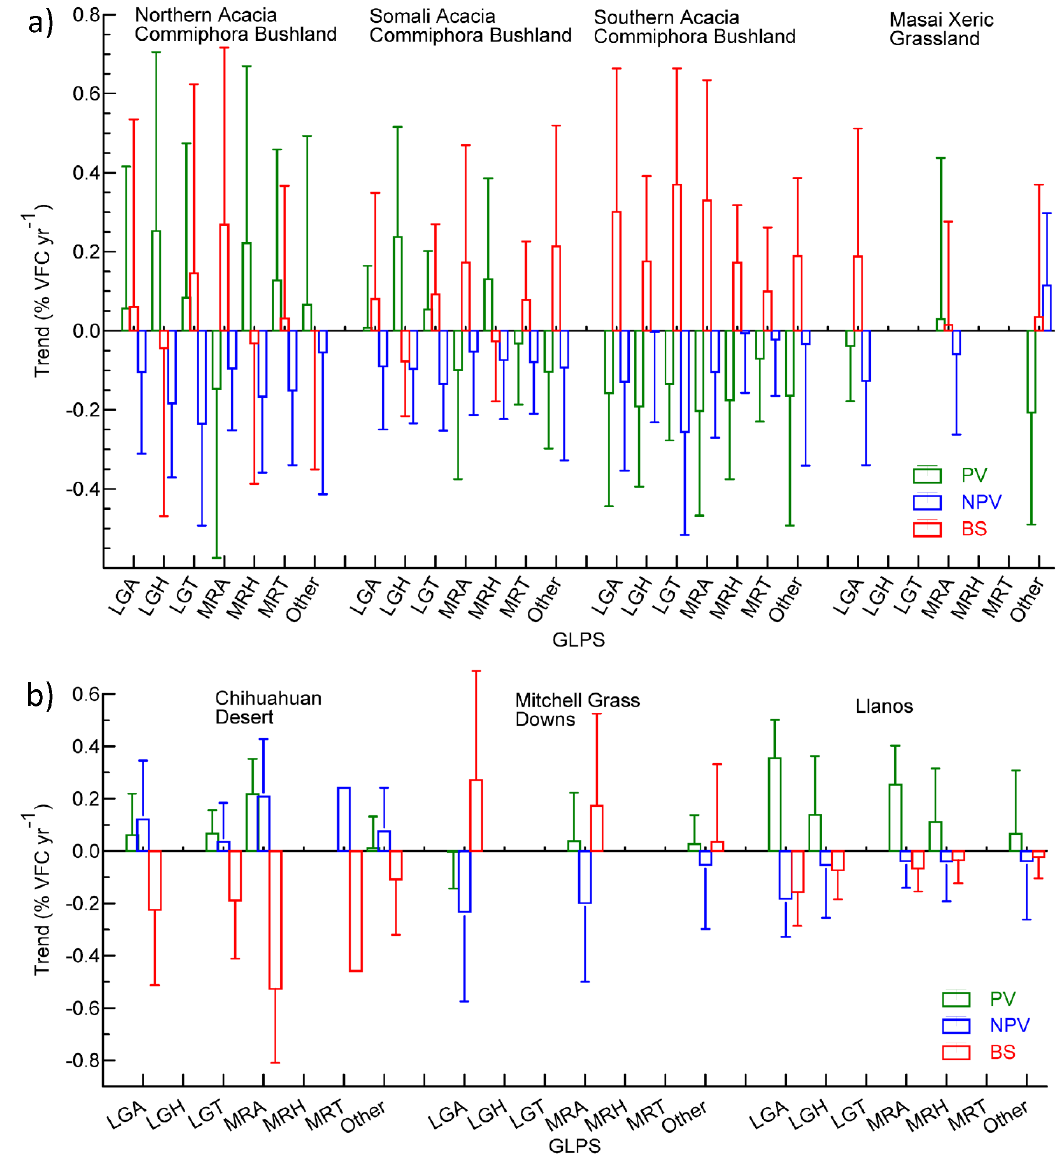
Figure 11. Trends in vegetation fractional cover among Global Livestock Production Systems (GLPS) areas within selected Ecoregions in ( a ) Africa; and ( b ) North America, South America, and Australia. The histogram indicates the average and the whiskers indicate the standard deviation among GLPS pixels within the Ecoregion.